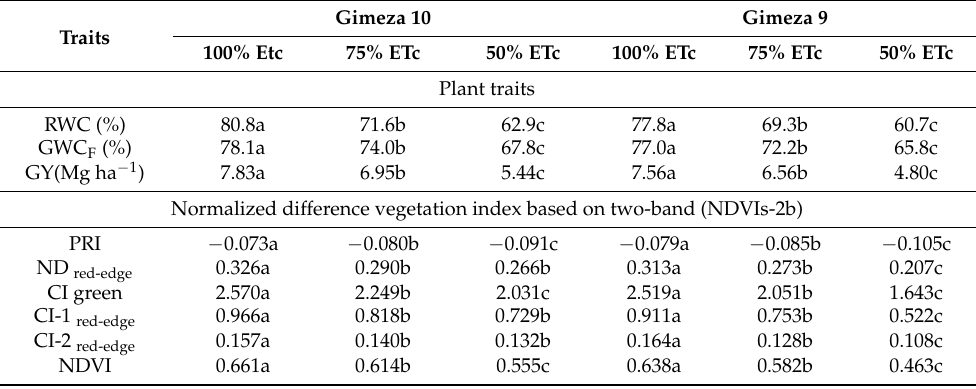
Table 3. Comparison of the mean values of the relative water content (RWC), gravimetric water content on a fresh weight basis (GWC F ), grain yield (GY), and twenty-four spectral reflectance indices of the wheat cultivars among three irrigation regimes for each wheat cultivar across two